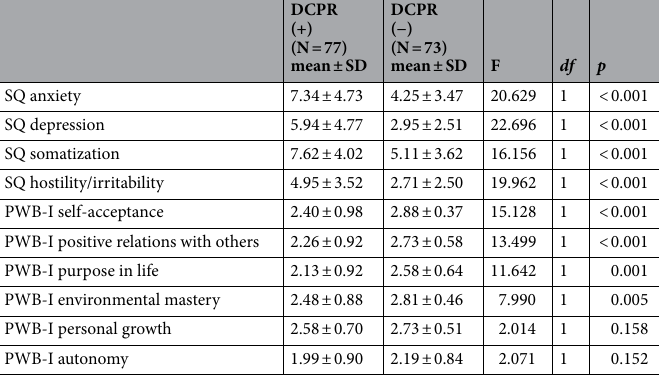
Table 2. Differences on SQ and PWB mean scores of participants with at least one DCPR syndrome compared with non-cases. (+) Syndrome present, (−) Syndrome absent, DCPR diagnostic criteria for psychosomatic research, PWB‑I psychological well-being interview, SQ Symptom